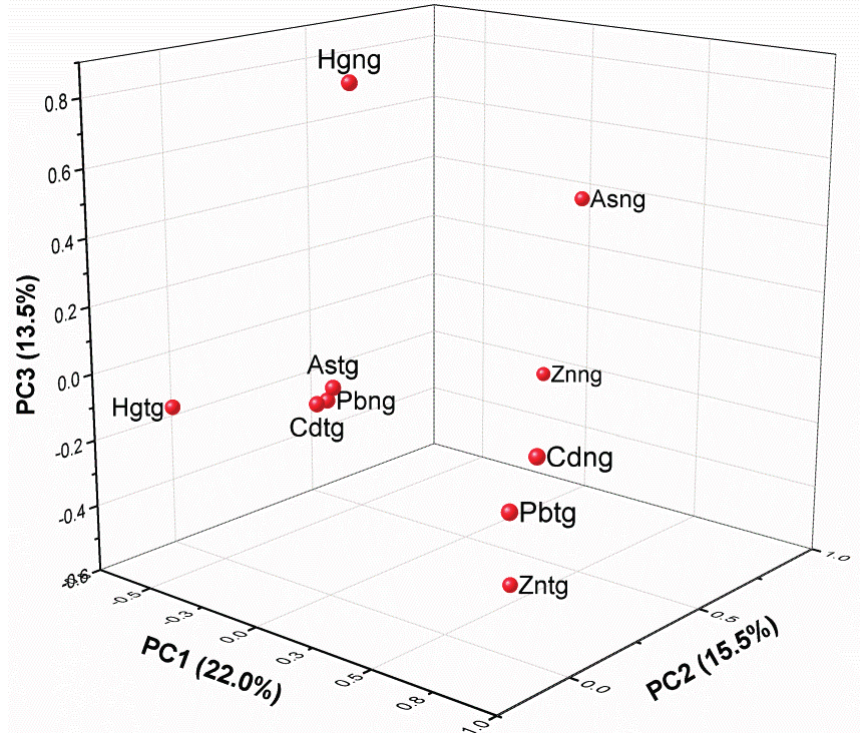
Figure 2. Principal component analysis (PCA) of heavy metals (Hg, Pb, As, Cd, and Zn) in the Nangodi (ng) and Tinga (tg) communities in northern Ghana. The first three components (PC1, PC2, and PC3) were more than 50.0% of total